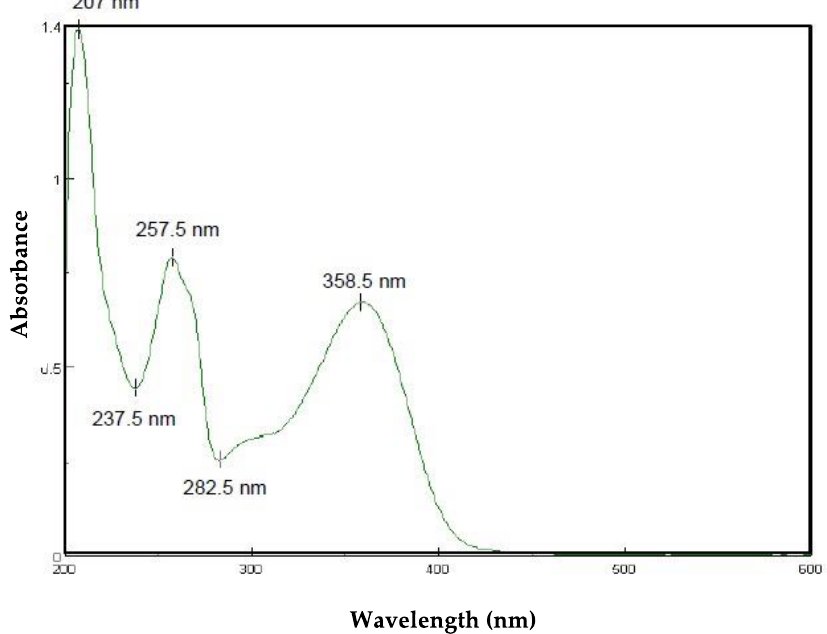
Figure 1. Absorption spectrum (absorbance vs. wavelength) of rutin obtained at the wavelength range of 200–600 nm (UV–Vis region).